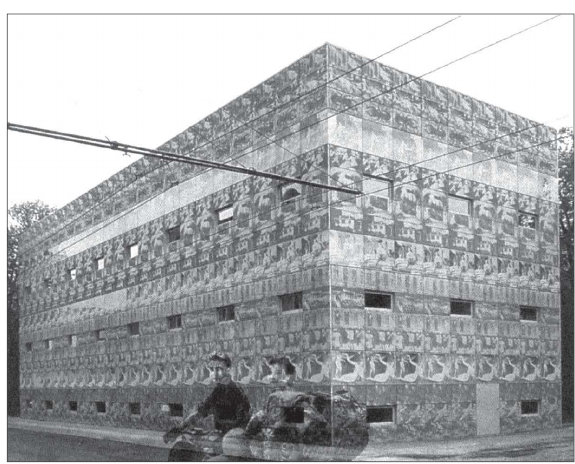
sukuriamomis erdvėmis ir šviečiančiomis arba perma- tomomis sienomis patys savaime stimuliuoja judėjimą.